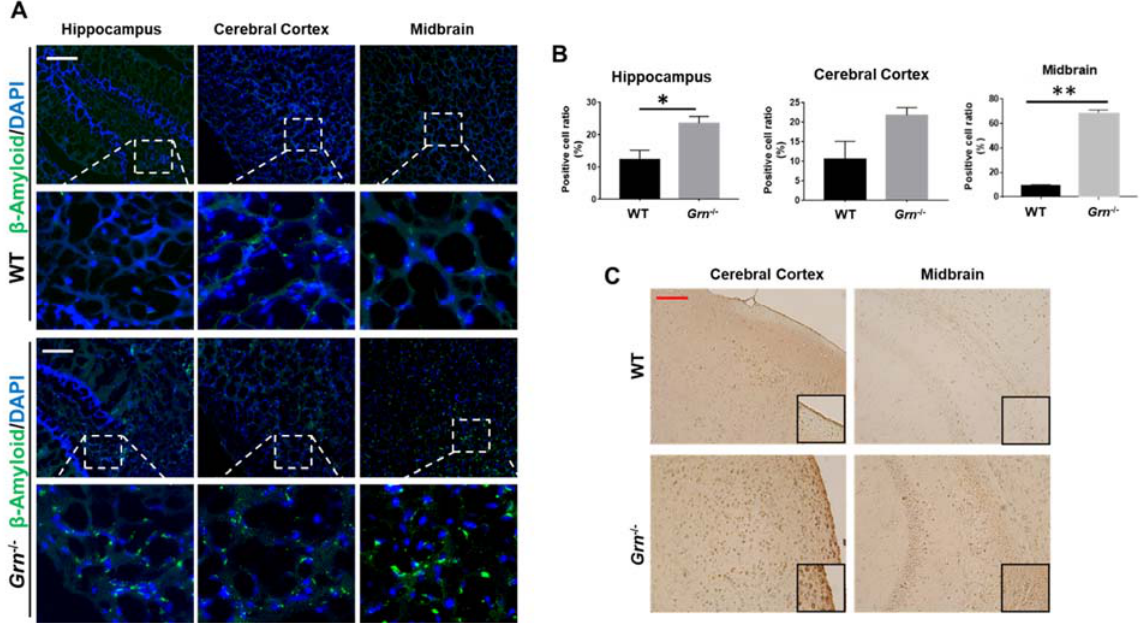
Figure 7. β‐ amyloid accumulated in aged PGRN ‐ deficient mice. Immunofluorescence and immuno ‐ Figure 7. β -amyloid accumulated in aged PGRN-deficient mice. Immunofluorescence and immuno- histochemistry staining of β‐ amyloid in the brain sections from 12 ‐ month ‐ old WT and Grn − /– mice. histochemistry staining of β -amyloid in the brain sections from 12-month-old WT and Grn − /– mice. ( A ) Representative images of β‐ amyloid accumulation in indicated brain regions by immunofluo ‐ ( A ) Representative images of β -amyloid accumulation in indicated brain regions by immunofluo- rescence staining. ( B ) The ratio of β‐ amyloid ‐ positive cells per section were quantified of A. ( C ) rescence staining. ( B ) The ratio of β -amyloid-positive cells per section were quantified of A. ( C ) Im- Immunohistochemistry staining of β‐ amyloid in the deparaffinized brain sections of 12 ‐ month ‐ old munohistochemistry staining of β -amyloid in the deparaffinized brain sections of 12-month-old WT WT and Grn − /– mice. Scale bar: 100 μ m. n = 3. Data presented as mean ± SD. * p < 0.05, ** p < 0.01. and Grn − /– mice. Scale bar: 100 µ m. n = 3. Data presented as mean ± SD. * p < 0.05, ** p <